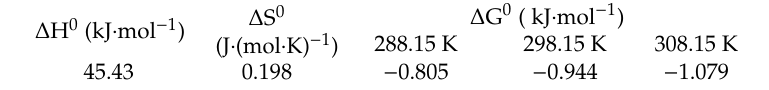
Table 3. The fitting thermodynamic parameters for CIP adsorption by